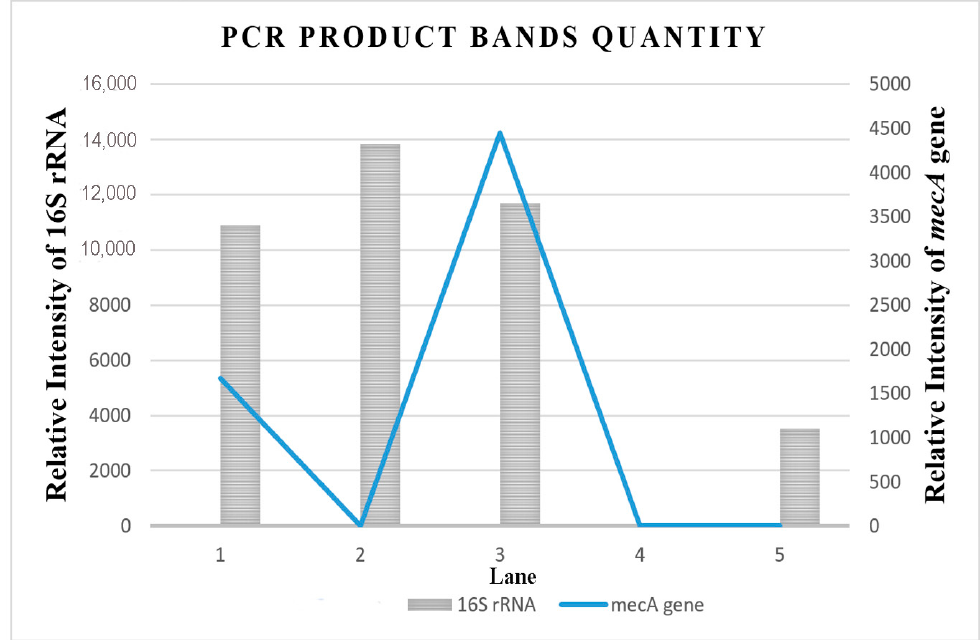
Figure 5. Relative band intensity by densitometry analysis of electrophoresis (3% agarose) gel of the PCR products of the mecA gene and 16S rRNA performed using ImageJ quantification software. Lane 1 = Treated MRSA isolate (in a combination of 1000 μ g/mL MEPL and 1000 μ g/mL ceftriaxone); 1 = Treated MRSA isolate (in a combination of 1000 µ g/mL MEPL and 1000 µ g/mL ceftriaxone); Lane 2 = Treated MRSA isolate (in a combination of 2000 μ g/mL MEPL and 1000 μ g/mL ceftriaxone); Lane 2 = Treated MRSA isolate (in a combination of 2000 µ g/mL MEPL and 1000 µ g/mL ceftriaxone); Lane 3 = untreated MRSA isolates, Lane 4 = blank, Lane 5 = MSSA isolate (control). Lane 3 = untreated MRSA isolates, Lane 4 = blank, Lane 5 = MSSA isolate